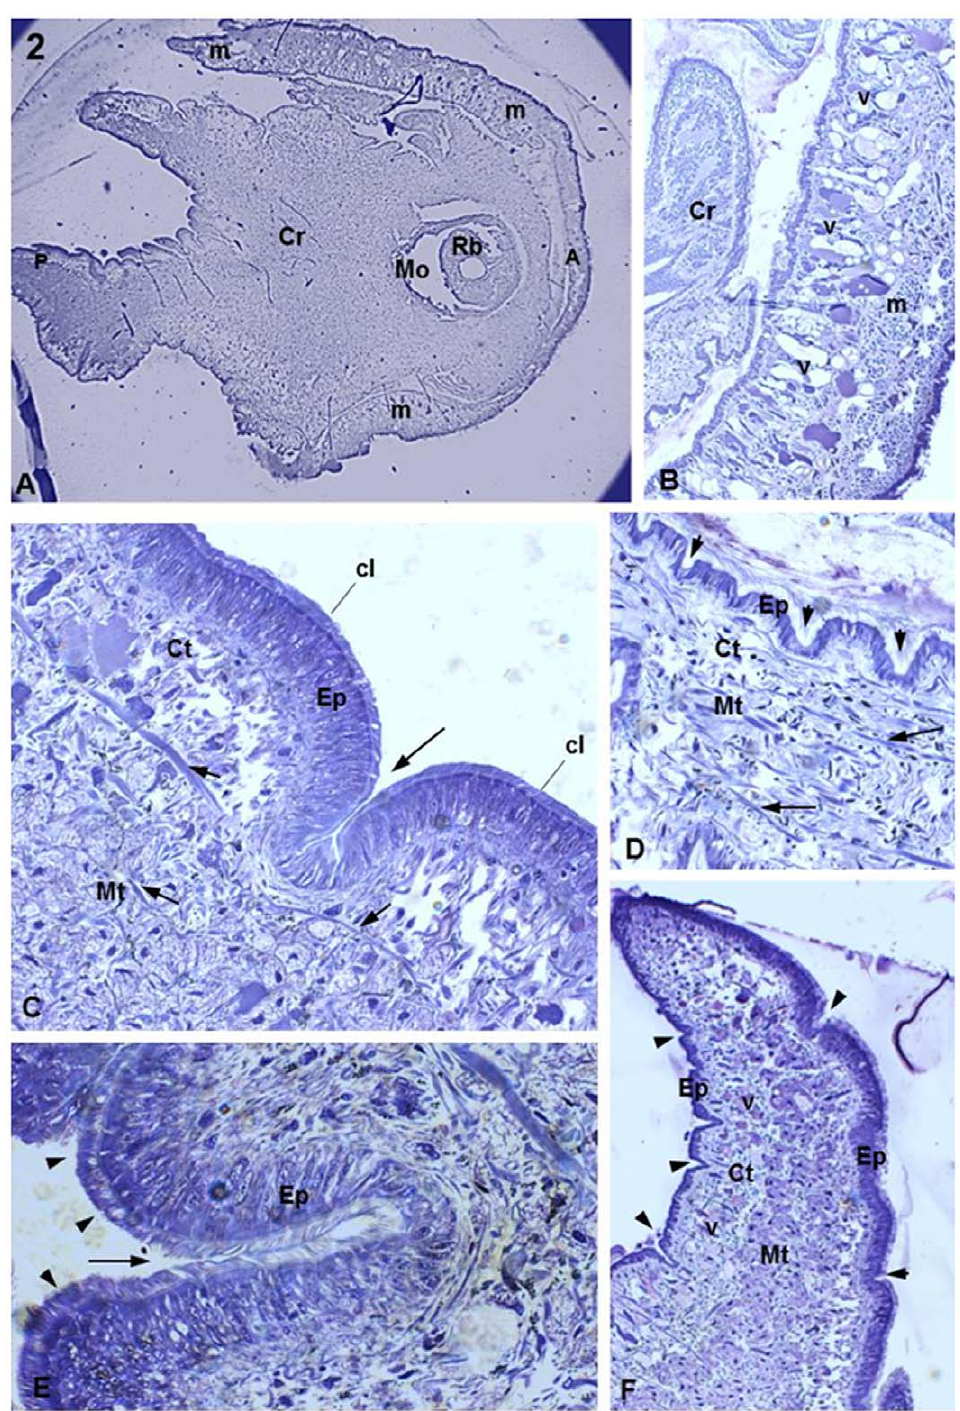
Figure 2. Histological sections of uninfected host B.tenagophila (control). ( A ) General view of the heat-foot region of B. tenagophila . Observe the mouth (Mo) near the anterior region (A), posterior region (P) and the mantle (m) that covers the heat-foot region (Cr). Magnification 2.5X. ( B ) Details of the region between the cr and the m. The lateral m region shows several types of vesicle (v) with distinct stain densities. Magnification 40X. ( C ) Details of the heat-foot region. Observe the ciliar cylindrical epithelium (Ep) and just below it the dense connective tissue (Ct) that is supported by the muscular connective tissue (Mt) comprising a network of muscle fibers (white arrow). A large crypt is seen that is similar to a large epithelial fold (large arrow). Small arrows indicate the cilia. Magnification 100X. ( D ) Detail of the heat-foot region, showing the Ep with several crypts (arrows) and moat-like invaginations. Key: Ct, connective tissue; Mt, muscle tissue; arrows, muscle fibers; arrowheads, crypts. Magnification: 40X. ( E ) Large magnification showing details of one crypt (large arrow) deep into the Ep. Details of the cilia on the epithelium are shown (arrowheads) Magnification: 100X. ( F ) Posterior area of the heat-foot region. Notice the presence of numerous v in the Ct supported by Mt. The Ep shows several crypts (arrowheads) Magnification 40X.